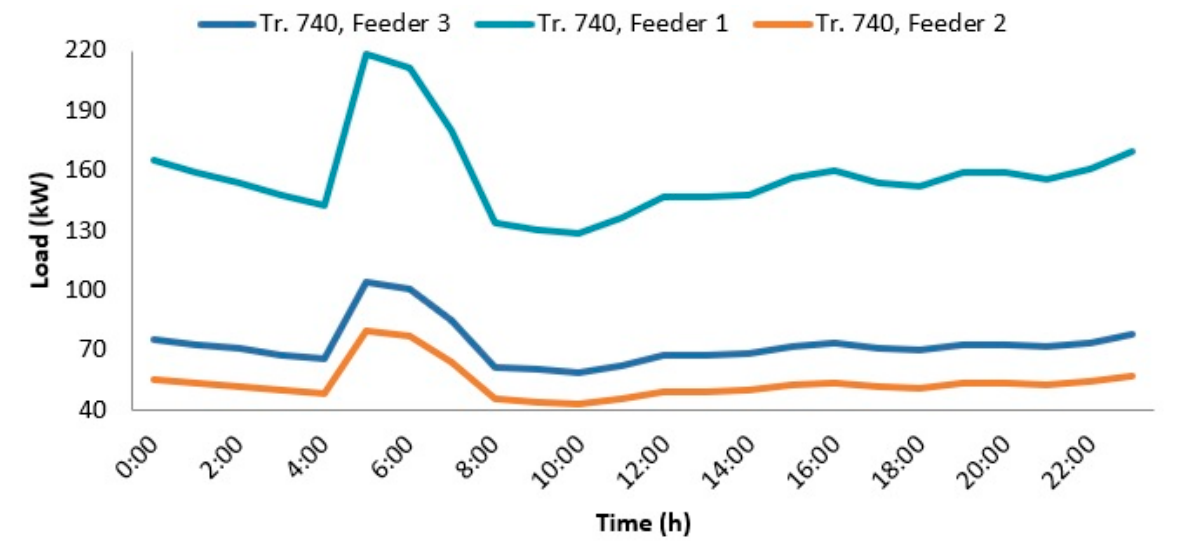
Figure 15. Load Profiles of Transformer 740 in summer with 60% EVC and overnight charging.